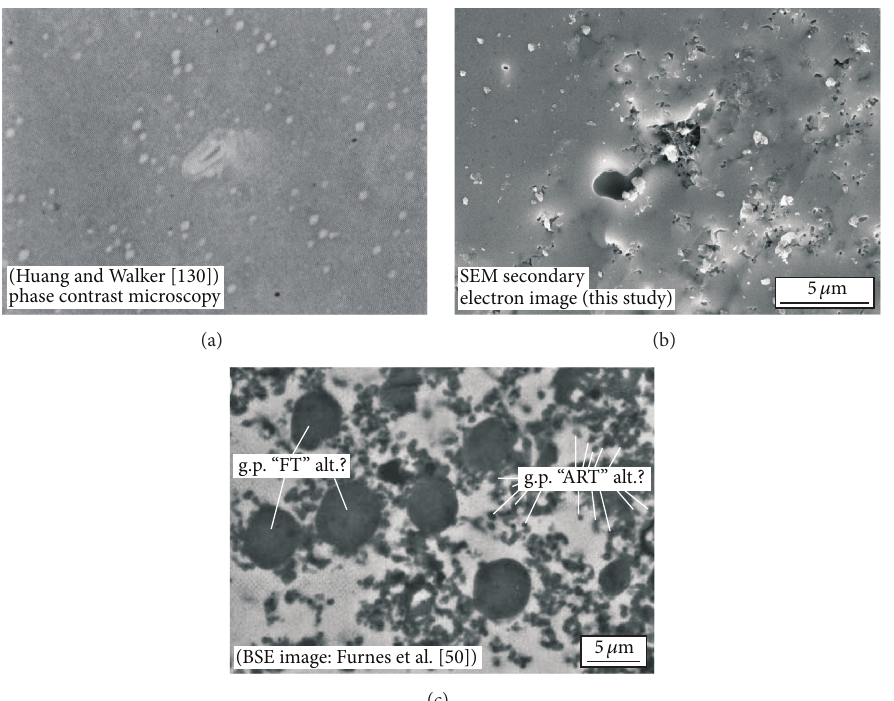
Figure 20: Three examples of “bimodal” distributions of microscopic corrosion features in geological samples—in each case, most likely related to the bimodal “size versus population (i.e., areal density)” distribution of fission tracks versus alpha-recoil tracks. (a) Phase contrast photomicrograph showing one large fission track etch-pit surrounded by a multitude of much smaller alpha-recoil track etch-pits on the experimentally etched cleavage surface of mica (from Huang and Walker [130]—no scale bar available). (b) SEM (secondary electron) image of one large fission track etch-tunnel surrounded by several much smaller alpha-recoil track etch-tunnels in DSDP-418A-75-3-[120– 123] basaltic glass (close-up from Figure 11(a)). (c) SEM (BSE) image of several large palagonite granules surrounded by a multitude of much smaller palagonite granules (from Plate 1 in Furnes et al. [50] of sample 148–896A-11R-1 , 111–113cm—from the Costa Rica Rift). The original interpretation is that both varieties of palagonite granules are biogenic in origin (i.e., “produced by the etching of microbes”: Furnes et al. [50]). However, in light of our newly proposed “abiotic” paradigm for interpreting corrosion microtextures in submarine glasses (Figure 19), we reinterpret the bimodal distribution of palagonite granules in (c) to have more likely arisen due to the concomitant, preferential palagonitization of several large fission tracks (granular palagonite “FT” alteration—labelled as “g.p. ‘FT’ alt.?”) and a multitude of tiny alpha- recoil tracks (granular palagonite “ART” alteration—labelled as “g.p. ‘ART’ alt.?”), during infiltration of